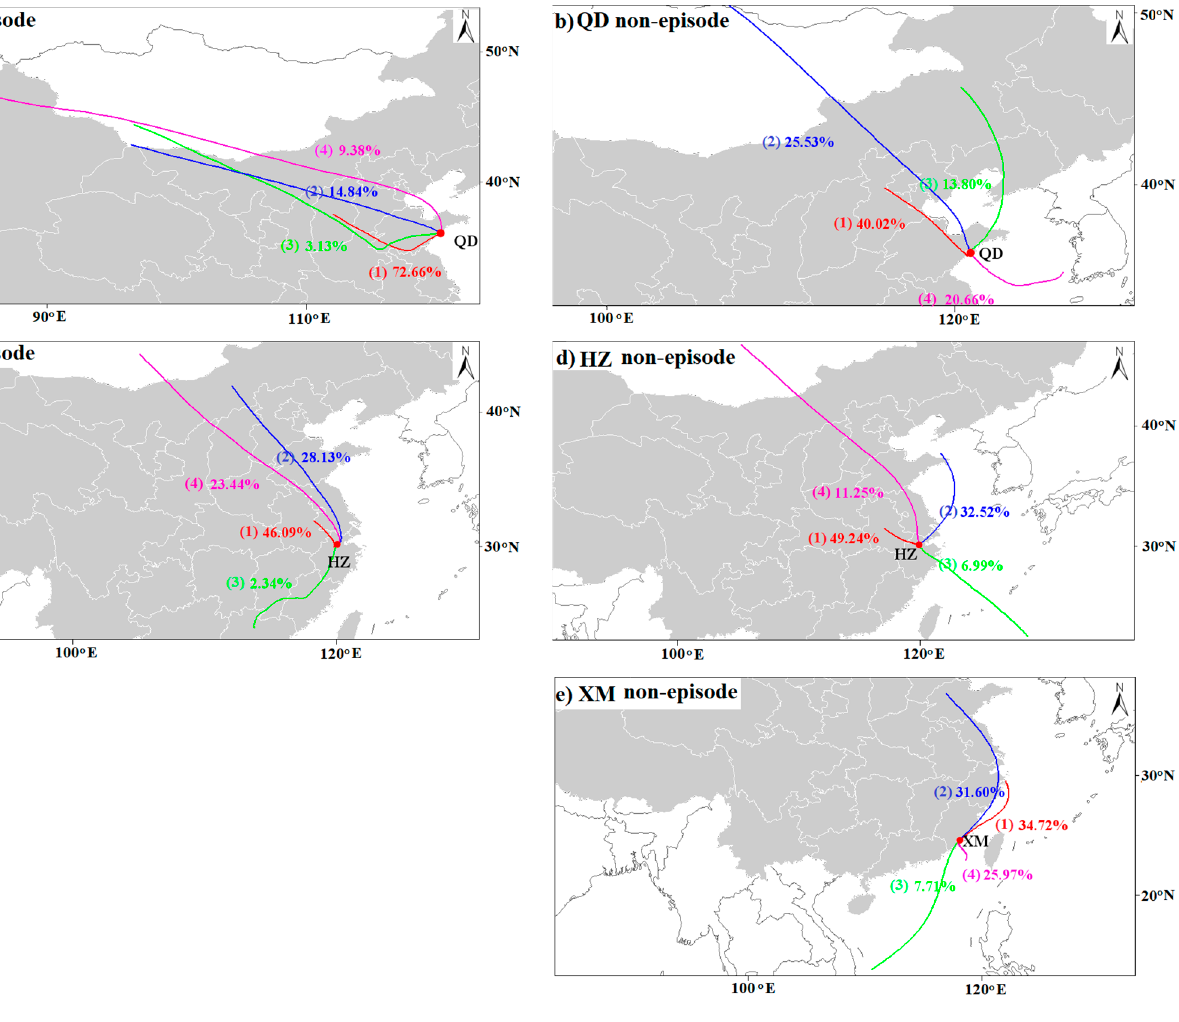
Figure 9. 72-h air-mass backward trajectories for episode ( a , c ) and non-episode ( b , d , e ) periods in Qingdao ( a , b ), Hangzhou ( c , d ), and Xiamen ( e ) during 2018. No pollution episodes occurred in Xiamen in 2018.